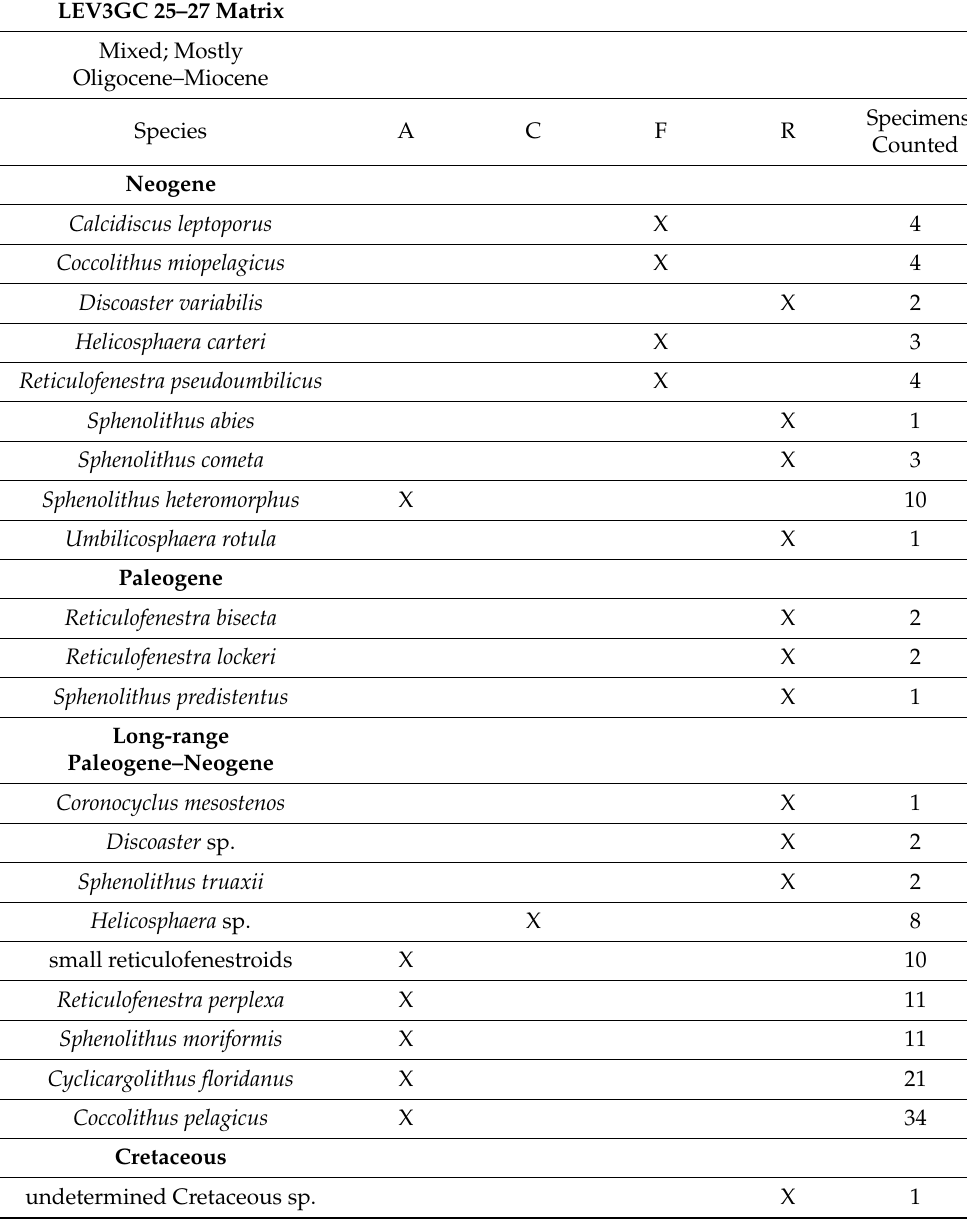
Table A14. Heraklion MV. LEV3GC 25–27 Matrix